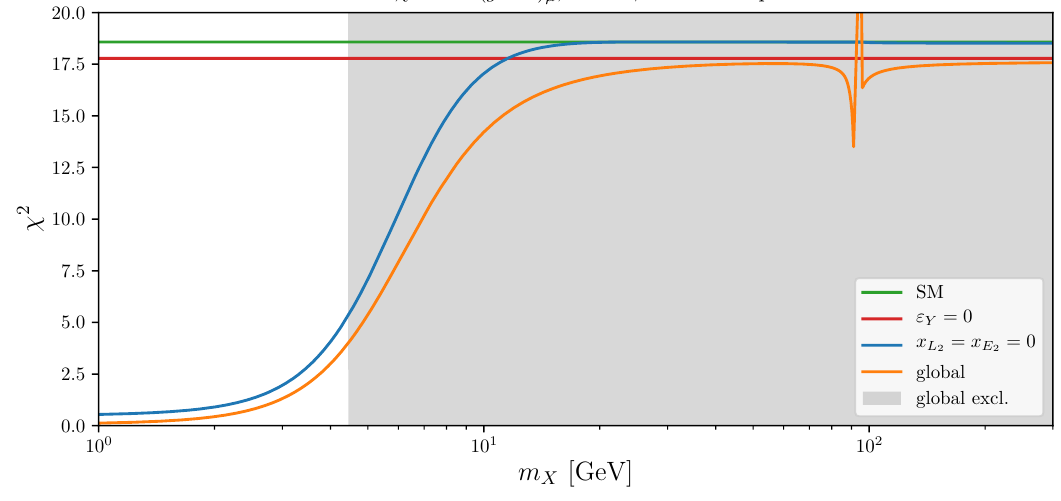
Figure 1 . Minimum χ 2 values in a model with a new X µ vector boson coupling to second generation leptons with charges x and x and a kinetic mixing with the hypercharge gauge boson ε from L 2 E 2 Y a fit to experimental data taking into account ( g − 2) , CCFR, and the EW T parameter (see the µ text for details). The orange curve is the global best fit χ 2 , the blue is the best fit in the absence of muon charges (dark photon), the red is the best fit for vanishing kinetic mixing, and the green line is the SM χ 2 . In the shaded grey region, ( g − 2) cannot be explained by any values of x , x , and µ L 2 E 2 ε Y while at the same time satisfying the constraints from CCFR and the electroweak T